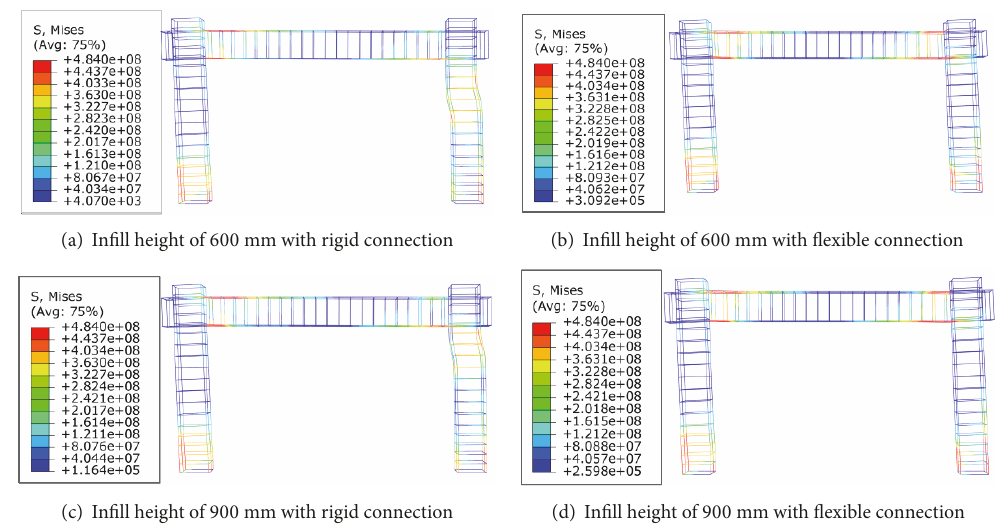
Figure 27: Stresses in reinforcement members in different connection